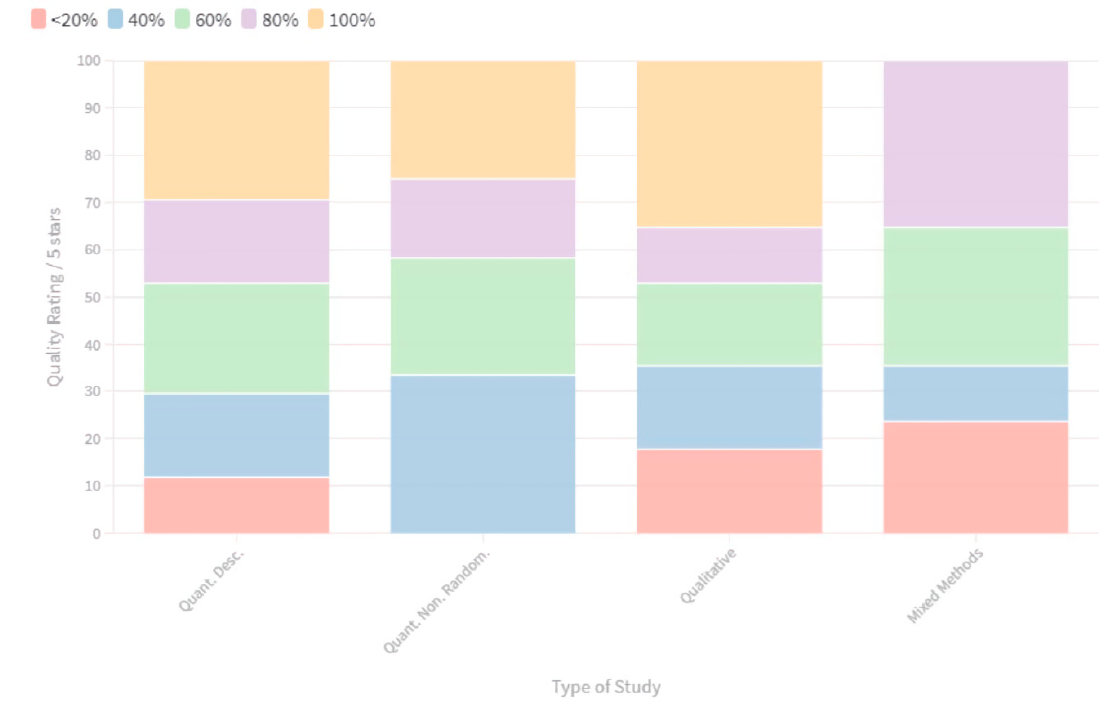
Figure 4. Quality Appraisal of included studies with MMAT: The majority of studies (approx. 70%) were of moderate—high quality according to the quality appraisal tool. Individual Quality Appraisal. The ranking system is according to the articles adherence to each of the MMAT 5 question criteria